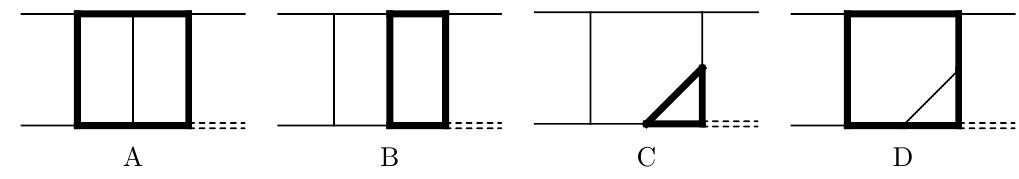
Figure 1 . The four planar integral families contributing to two-loop H + j -production in QCD. other series are (cid:12)xed by imposing that two consecutive series have the same value in the contact point, i.e. the point where they are both